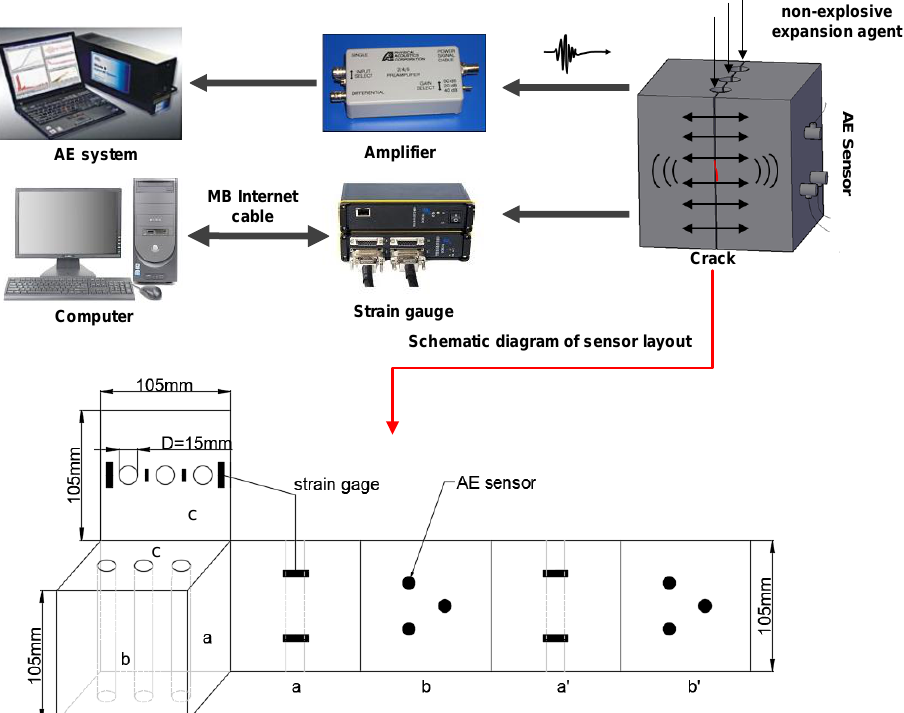
Figure 2. Schematic diagram of the AE test of non-explosive fracturing agent expanding rock [38]. The non-explosive fracturing agent is injected into the three boreholes of the rock sample, and a fracture surface is formed in the center of the three boreholes.